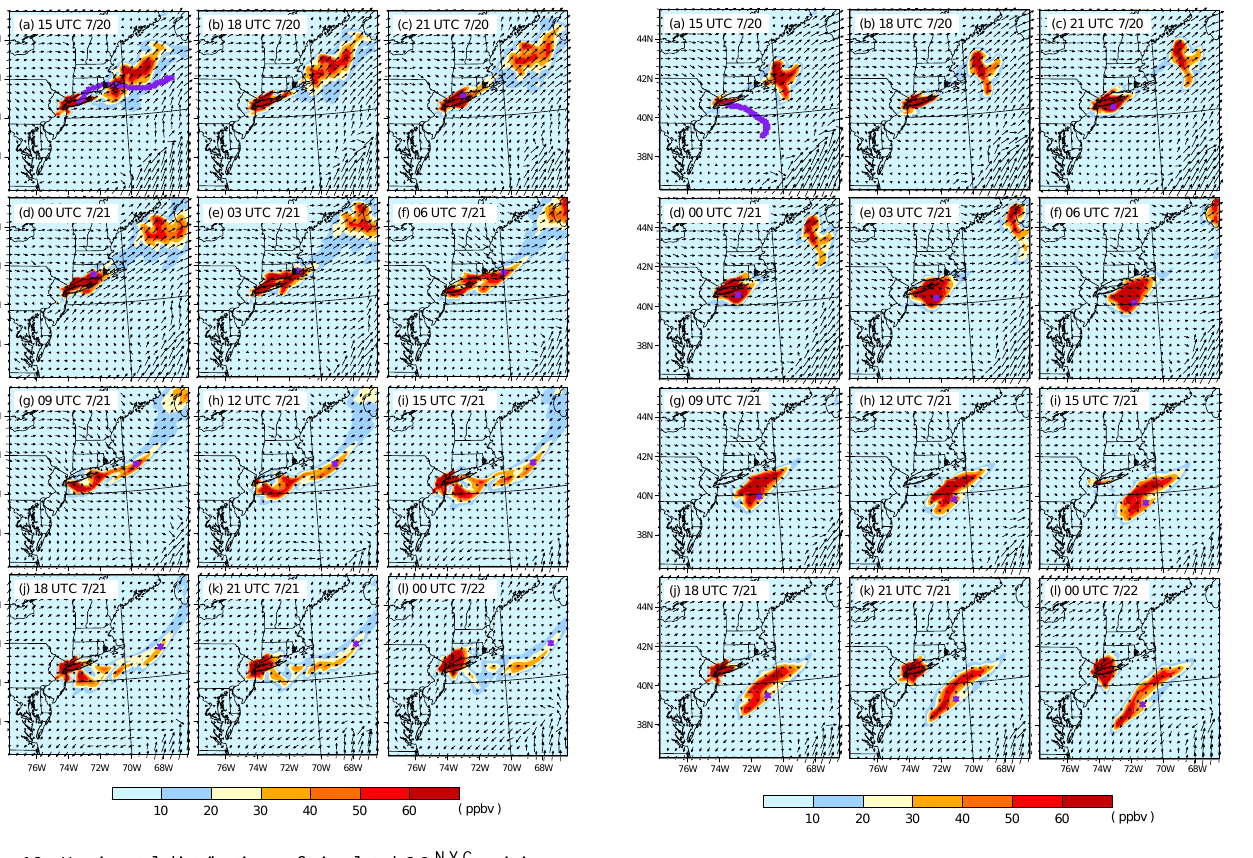
forward trajectories of the lower and upper plumes defined above. At the initial time 18:00 UTC on 20 July, the NYC urban plumes are well mixed vertically up to about 1.8 km.